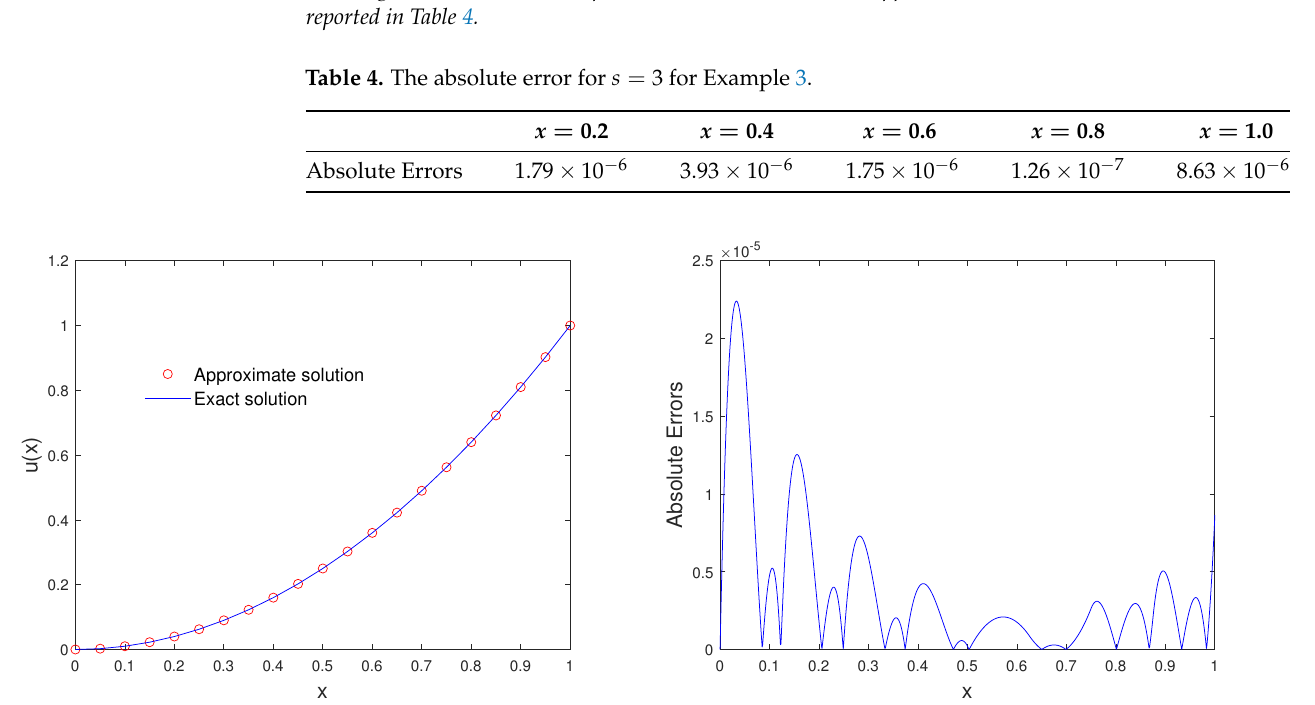
Figure 4. Comparing the approximate and exact solutions, taking s = 3, for Example